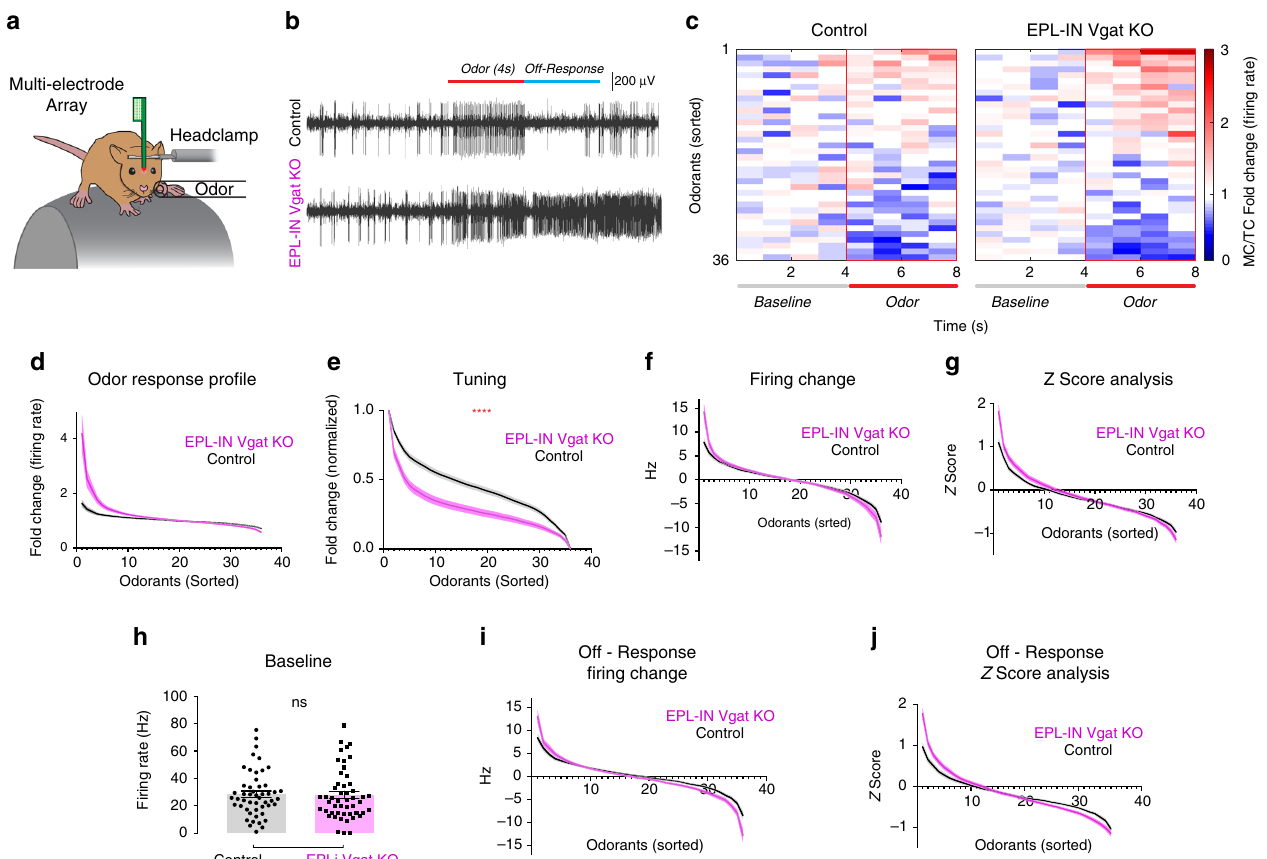
Fig. 2 TC/MC odor responses elevate without EPL-IN inhibition. a Experimental setup. b Representative TC/MC odor response. c Representative single cell odor response pro fi le from TC or MC of control and EPL-IN Vgat knockout mice. d Average TC/MC odor response pro fi les of control and EPL-IN